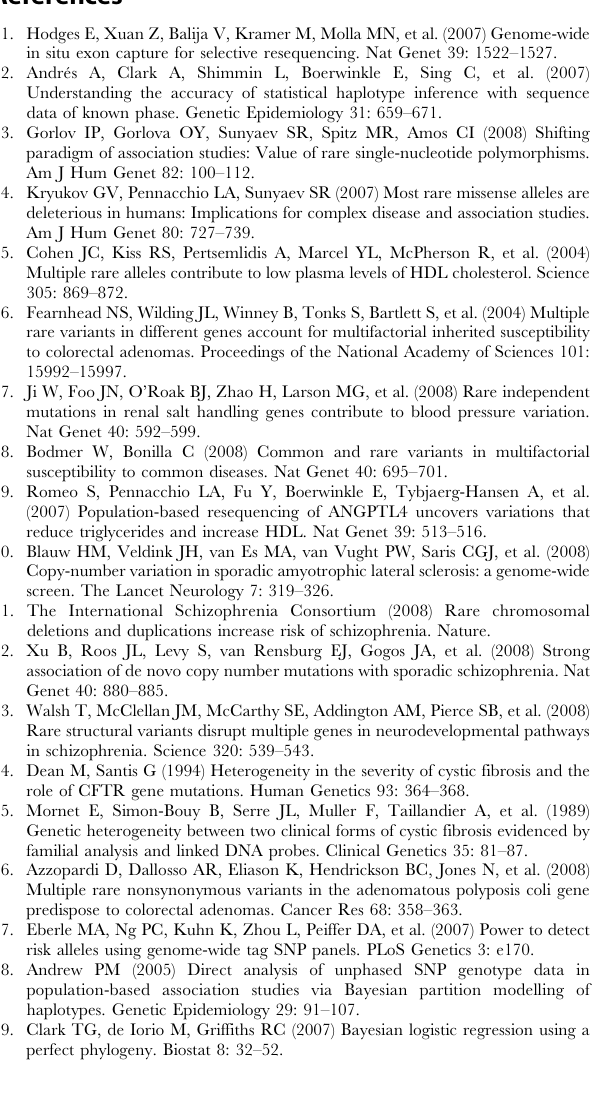
shown for different levels of probability of mutant-haplotypes ( p M ). The power simulations were performed using n A = n U = 1000 individuals, 50 D-variants, 50 N-variants and group PAR of 10%. Table S1 Number of individuals needed to identify a disease- associated group, using the CMC method. The power (in %) of the CMC method is shown for different number of individuals n = n A = n U , and different levels of group PAR (in %). The power simulations were performed using 50 D-variants, 50 N-variants and p M = 10%. Table S2 Number of individuals needed to identify a disease- associated group, using the CAST method. The power (in %) of the CAST method is shown for different number of individuals n = n A = n U , and different levels of group PAR (in %). The power simulations were performed using 50 D-variants, 50 N-variants and p M = 10%.